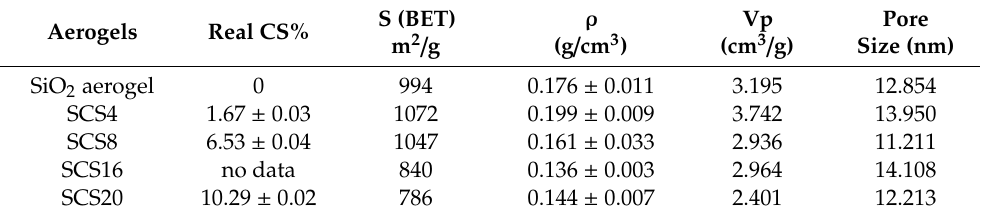
Figure 1. Sol-gel process assisted with high-power ultrasounds ( A ). Aging and solvent exchange in ethanol ( B , C ), Dried in an autoclave under supercritical conditions of CO 2 ( D ). Monolithic aerogels were obtained ( E ). Table 1. Textural parameters of the silica/CS aerogels; the number in the sample code refers to the CS wt% content. Column 2 is the result of the chemical analysis.